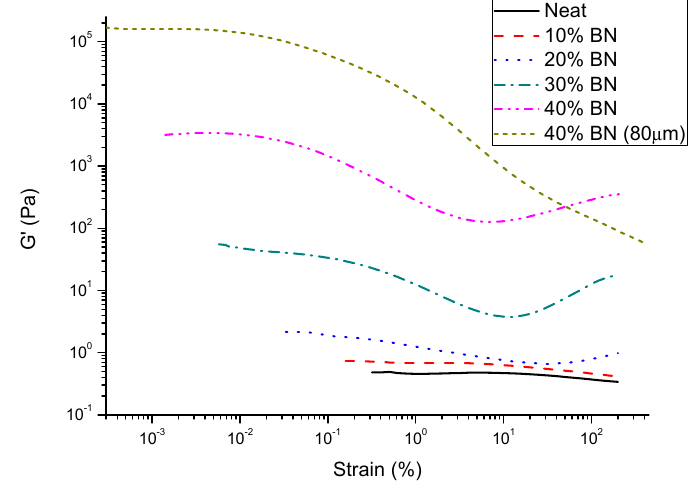
Figure 2. Plot of log G ′ versus log % strain in oscillatory experiment (1 Hz) of uncured formulations.